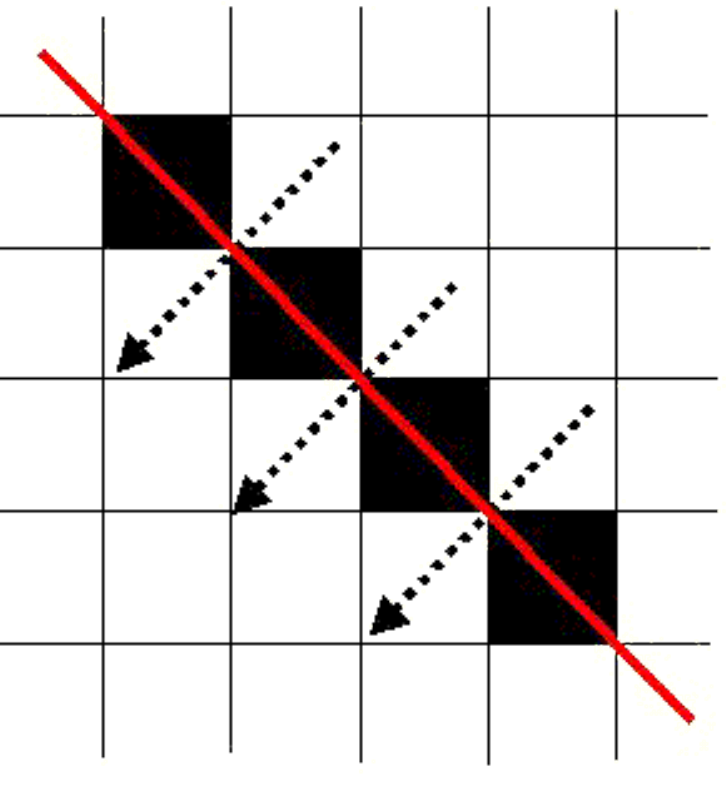
Fig. 1 . A linear landscape feature represented in a raster format. The red line shows the feature. The black pixels show the raster representation of the feature. The dashed arrows indicated the location of cracks in the feature where organisms can diagonally sidestep across the feature (adapted from Fig. 4 in Adriaensen et al.